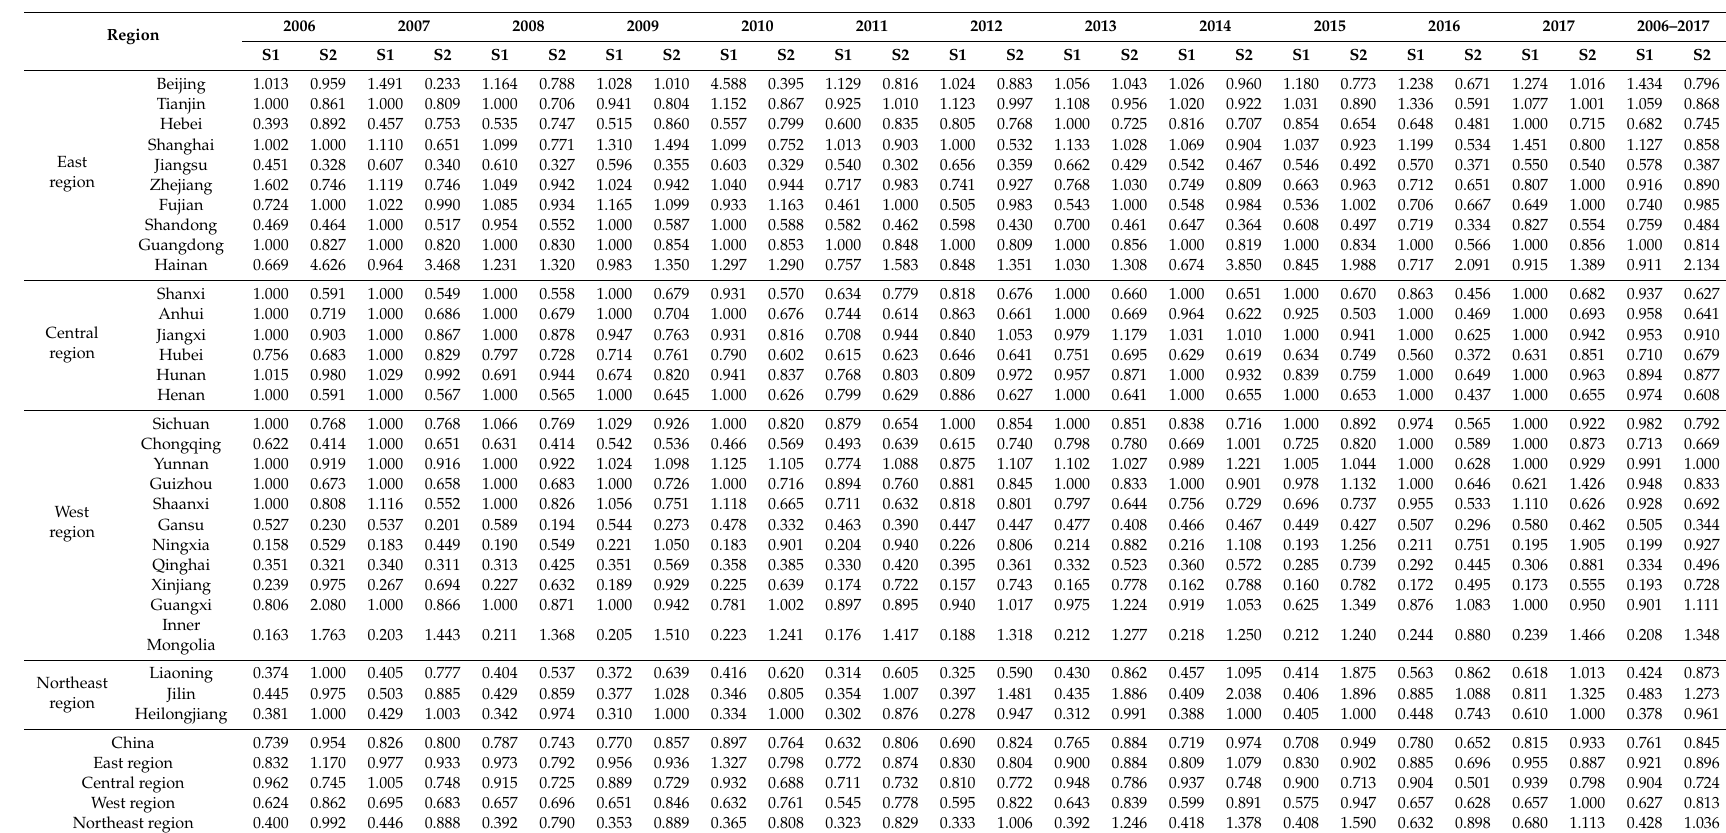
Table 4. The EWPs in stage S1 and S2 from 2006 to